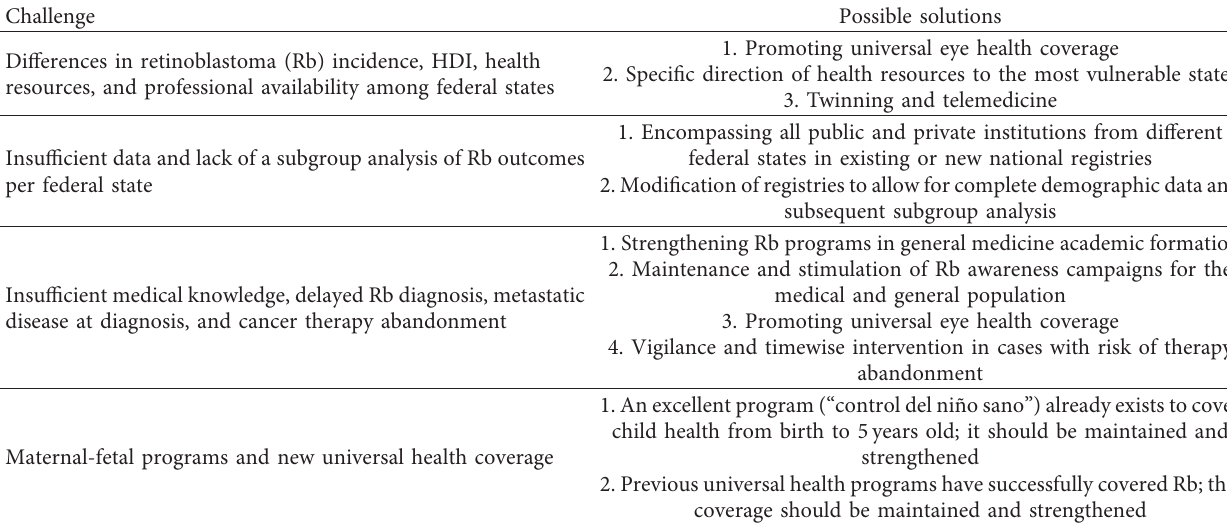
Table 1: Challenges and possible solutions for improving retinoblastoma outcomes in